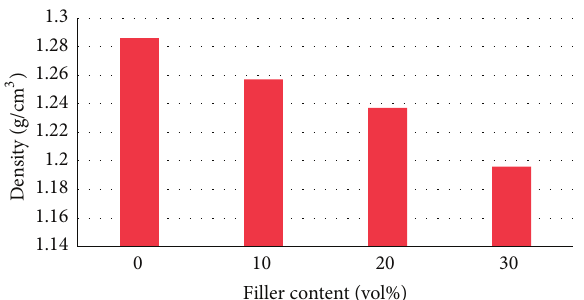
Figure 3: Density of UPE/OPS composites.